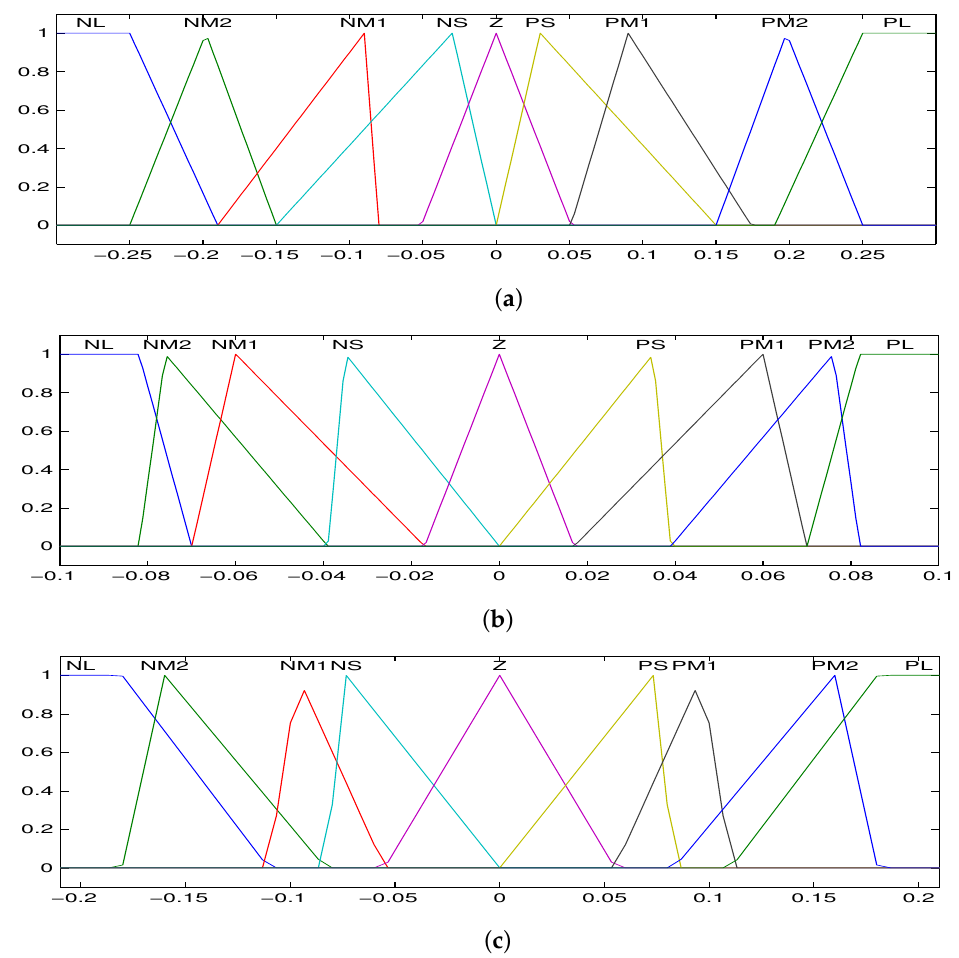
Figure 13. ( a ) First input membership functions for the first fuzzy logic control (FLC) scheme; ( b ) second input membership functions for the first FLC scheme; ( c ) output membership functions for the first FLC